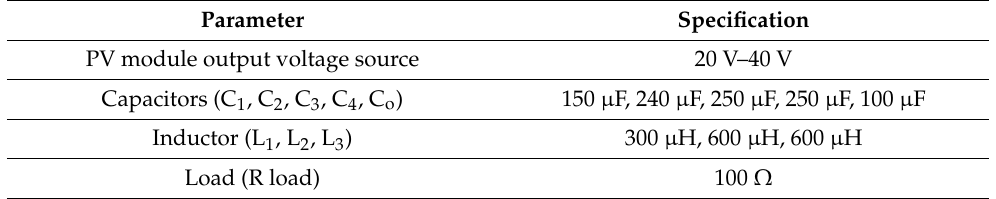
Table 1. Component parameters used in the MATLAB simulation for the proposed HVGSU converter.